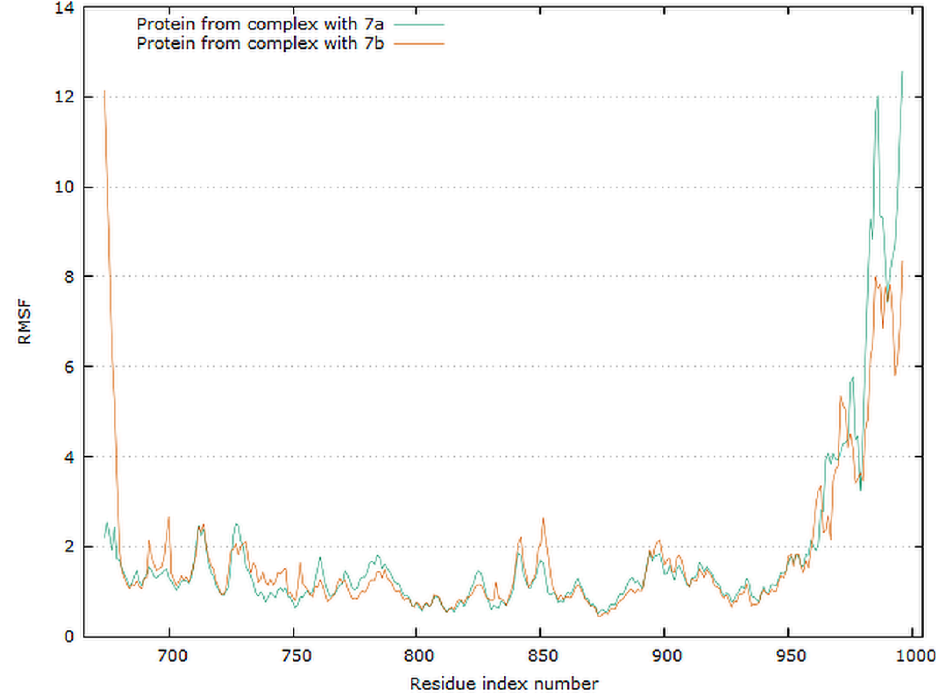
Figure 16. Graphical representation of the plots showing proteins RMSF [Å] versus residue index number of protein for 7a and 7b complexes of EGFR tyrosine kinase.